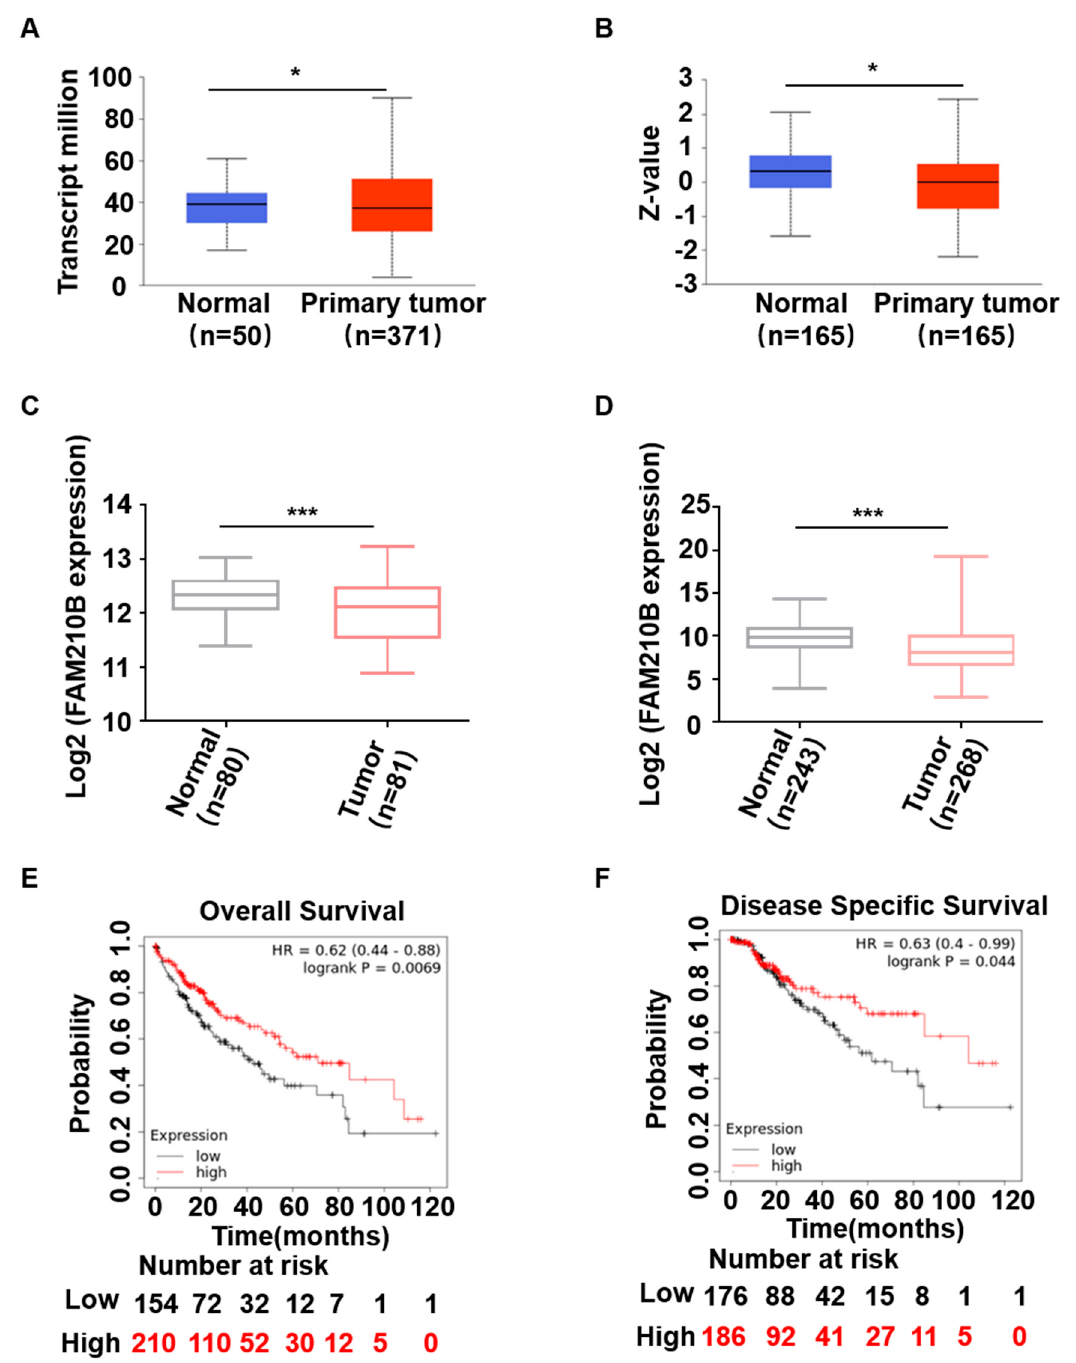
Figure 1. Low expression of FAM210B in HCC patients and was linked to poor prognosis. ( A ) The expression of FAM210B mRNA comparing the HCC tissues with the normal liver tissues in TCGA. ( B ) The expression of FAM210B protein in normal tissues or HCC samples in CPTAC confirmatory/discovery dataset. ( C ) The expression of FAM210B mRNA in GSE54236 normal and HCC samples. ( D ) The expression of FAM210B mRNA in GSE25097 adjacent non-tumor and HCC samples. ( E , F ) Kaplan − Meier curves showing overall survival and disease-specific survival were plotted according to the relative FAM210B expression levels from TCGA − LIHC data. *: p < 0.05; ***, p < 0.001 3.2. The Expression Level of FAM210B Was Reduced in Clinical Tissues of HCC.